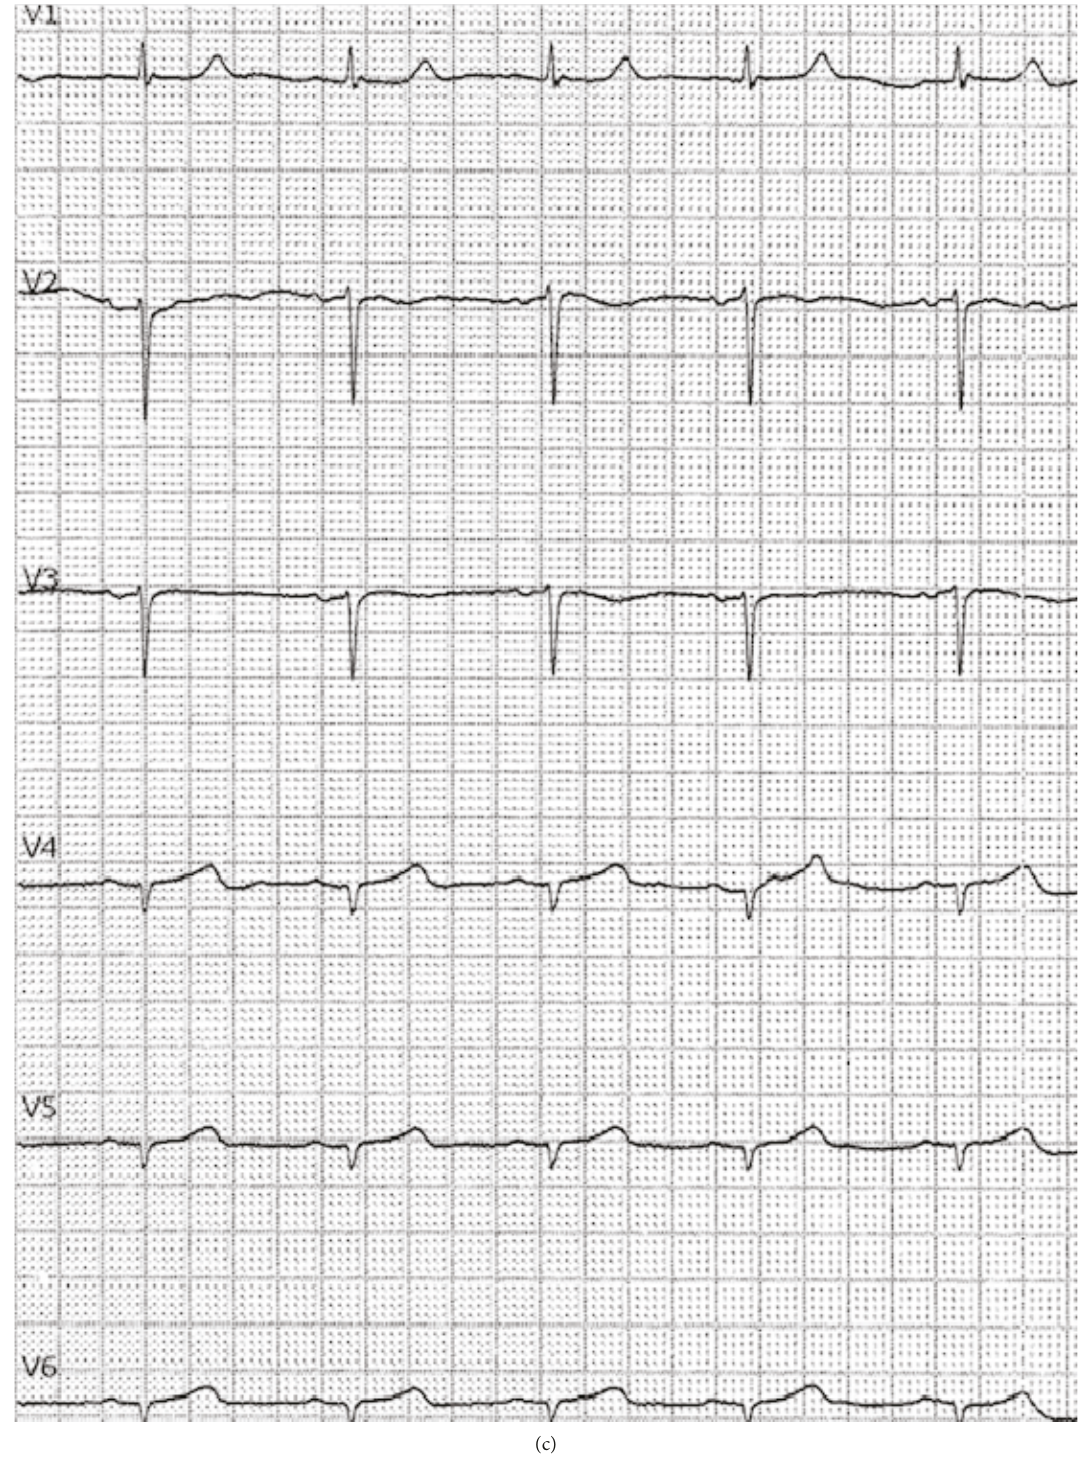
Figure 1: (a) ECG at admission (I, II, III, aVF, aVL, and aVF). (b) ECG at admission (V1-V6). (c) ECG at admission (right